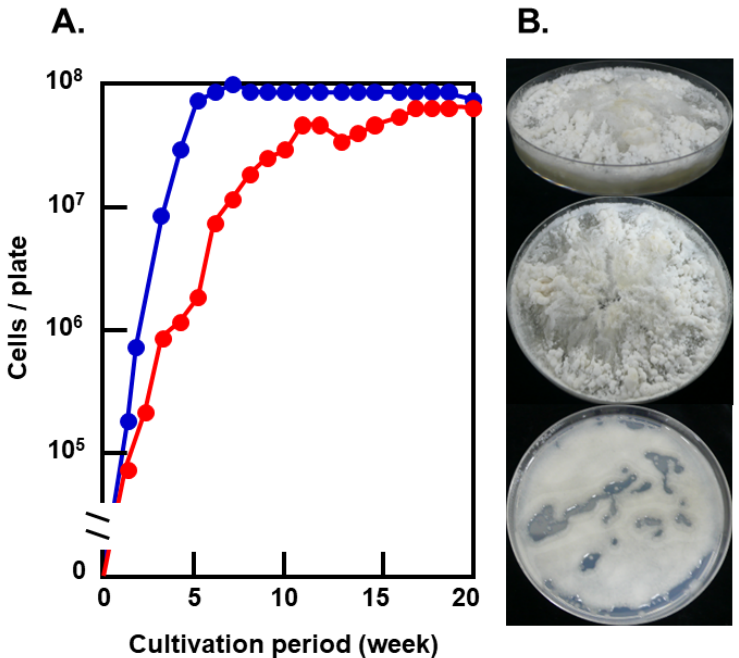
Figure 4. Growth of G. antarctica at − 1 °C on PDA. ( A ). Growth of G. antarctica on unfrozen PDA (blue) and frozen PDA (red). ( B ). Frozen PDA cultures at − 1 °C for 20 weeks (top and middle) and unfrozen PDA cultures at − 1 °C for 5 weeks (bottom).